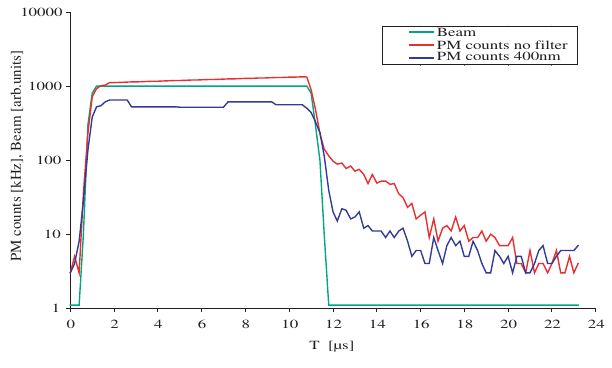
FIG. 14. (Color) Afterglow